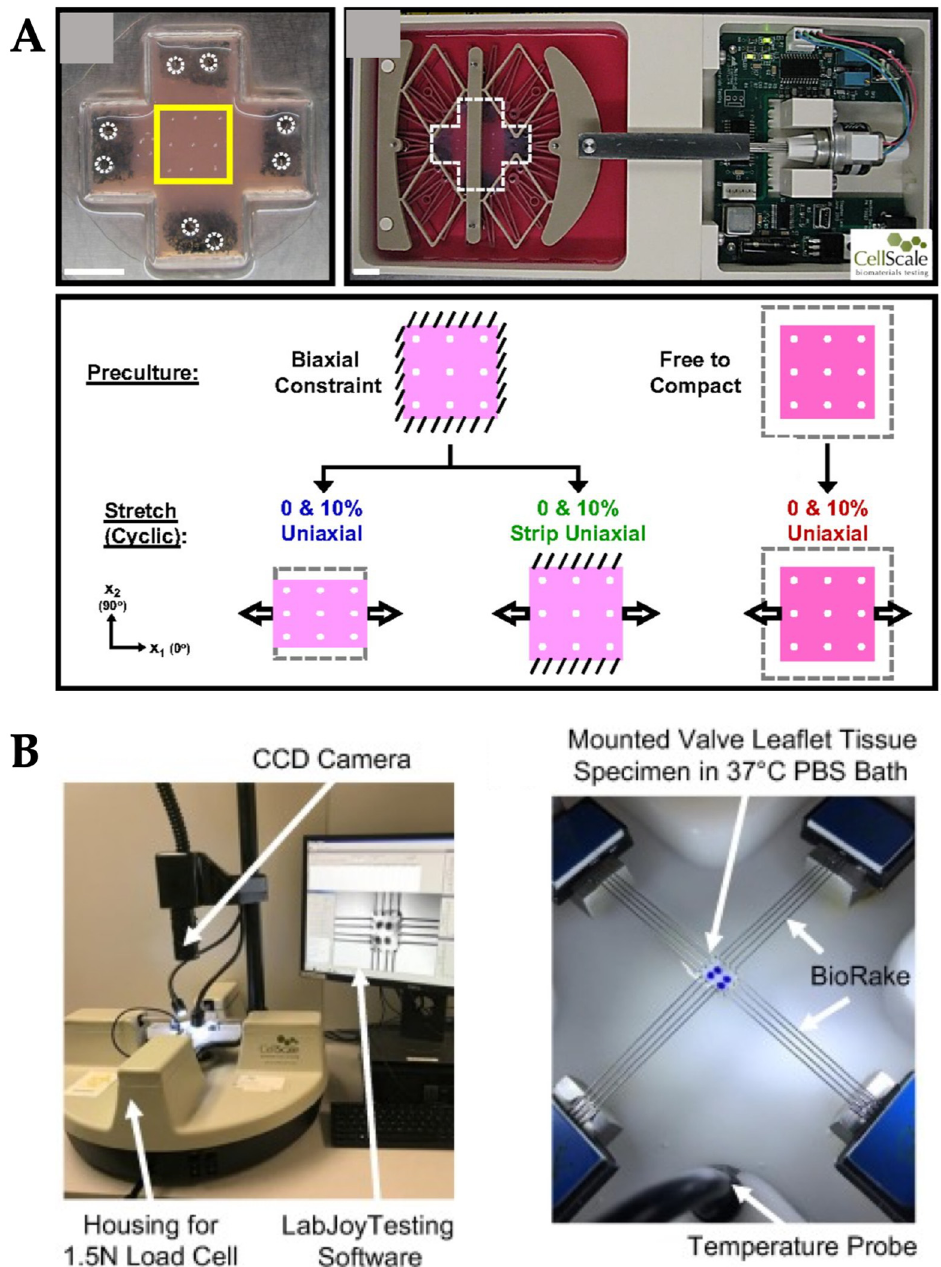
Figure 7. Examples of commercially available OOC systems with stretch and strain stimuli. ( A ) Microfluidic device was inserted to the MechanoCulture B1 system from CellScale Inc. to provide the biaxial mechanical stretch stimulation and evaluate its effect on cell alignment. Reproduced with permission from Reference [61]. ( B ) Porcine heart valves were positioned in the biaxial mechanical tester (BioTester, CellScale Inc.) to characterize heterogeneity of heart valve leaflet. Reproduced with permission from Reference